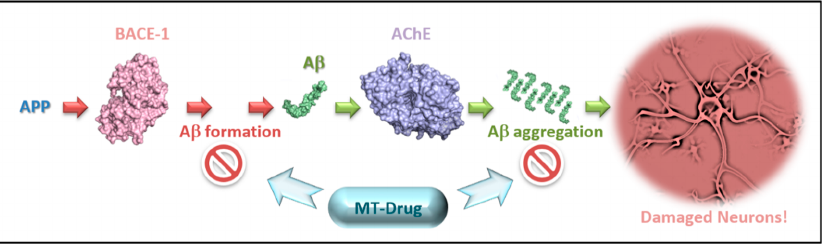
Figure 1. A MT (multi-targeted) drug could bind to both targets, BACE-1 (pink colored) and AChE (violet colored), so the two processes: A β peptide (green colored) formation from APP and A β ag- gregation. would be blocked. Additionally, by blocking AChE in the PAS, the level of non-hydro- lyzed acetylcholine neurotransmitter would rise, thus, improving cholinergic activity simultane- ously with the reduction in aggregation. The protein illustrations were made with Pymol software, Schrödinger and the PDB structure codes: 4M0F (AChE), 4DJW (BACE-1) and 1IYT (A β 42). Most of the attempts to design dual inhibitors were focused on combining two scaf- folds: one that binds AChE (e.g., tacrine, or N-benzylpiperidine moiety of donepezil) and another that binds BACE-1 (e.g., oxo-chromene) to form one molecule with dual activity [27,28]. Another study combined scaffolds of AChE and BACE-1 ligands by overlapping them to produce new dual inhibitors [29]. In some cases, the combination of scaffolds did not include a BACE-1 binding moiety, but the candidates were still tested for inhibition of that enzyme [30–33]. Contrary to much computational work for discovering AChE inhib- itors, [34–38] there are few publications on computational methods for identifying dual inhibitors of AChE and BACE-1 that were also tested in vitro [39,40]. Here, we present a method for identifying dual inhibitors by screening large data- bases through ligand-based classification models, followed by docking the top candidates into crystal structures of both protein targets. Our efforts led to the final purchase of 36 candidate inhibitors out of virtually screen- ing ca. 3.2 million molecules from various databases. In vitro experiments identified two novel AChE and BACE-1 dual inhibitors, with one of the two also showing in vivo activity by inhibiting A β 42 aggregation in a mouse model. Additionally, in vitro testing of the 36 predicted inhibitors found that some of them were active on one of the two targets and not on the other (AChE or BACE-1). 2. Methods 2.1. Preparation of the Classification Models and Screening 2.1.1. Initial Preparation and Filtration of Datasets Datasets containing BACE-1 and AChE inhibitors (for homo sapiens) were down- loaded from the ChEMBL database [41]: BACE-1 data in November 2012 and AChE data in February 2014. Both underwent the rejection of duplicates, excluding molecules with too high activity values. Further processing was performed in order to reduce the bias of our modeling, which might be due to high similarity between the inhibitors. We identified similarity by calculating the Tanimoto index (TI) between all pairs of molecules. We ex- amined the effect of molecular diversity by applying several cutoffs of TI values in the range of 0.7–1.0 and rejecting molecules that had TI above the cutoff values. Tanimoto indexes were calculated by OpenBabel using FP2 fingerprints. Models were built for each diversity value, and the models were evaluated by statistical criteria (see Tables 1 and 2 in the results section).